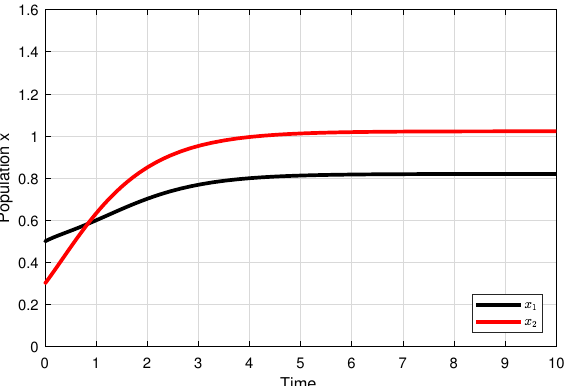
Figure 4. Evolution over time of the occupancy levels of two patches with different noise levels (more noise: black line; less noise: red line), when noise intensity is high. In this simulation, k = 0.5, i.e., the carrying capacity of the noisy patch ( K 1 ) is lower than that of the less noisy patch ( K 2 ).